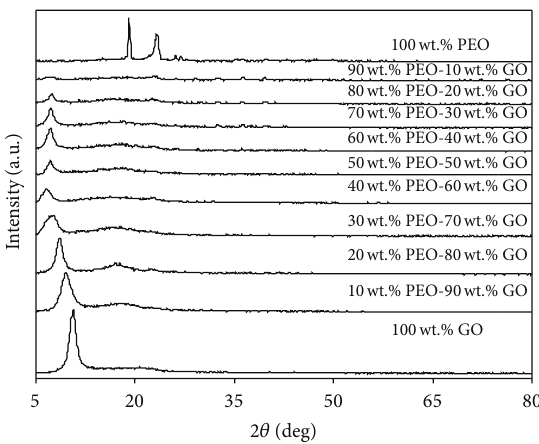
Figure 2: XRD pattern for pure PEO (100wt.% PEO), pure GO (100wt.% GO), and different ratio (wt.%) of PEO-GO blends.